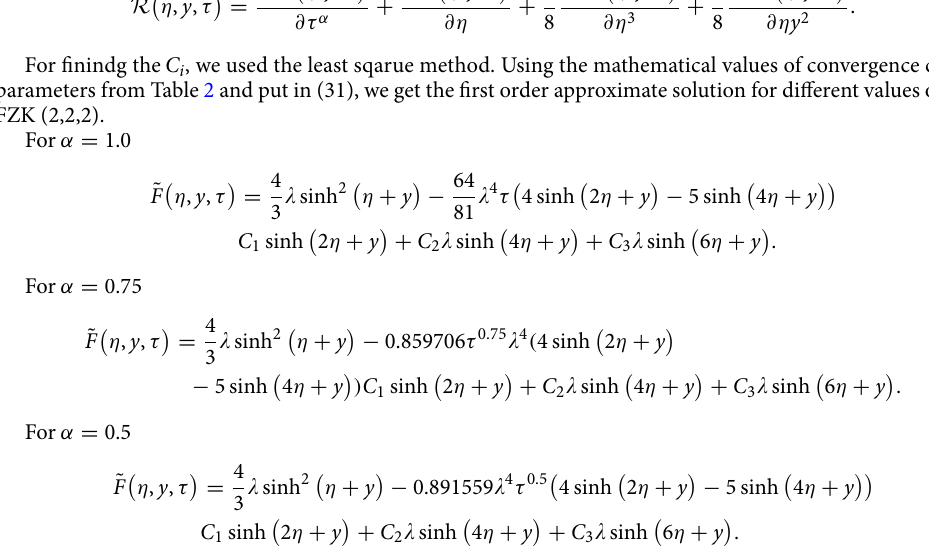
Figure 1 shows 3D plots approximate verses exact solutions for the nonlinear fractional order FZK(3,3,3) equation when α = 1, y = 0.1 . Figure 2, displays the 2D schemes of the residual, obtained by the suggested technique for α = 0.5 to fractional order FZK(3,3,3) equation. Figure 3, displays the 2D designs of approxi- mate solutions obtained by the suggested mode for different values of α while τ = 0.1, y = 0.2 to fractional order FZK(3,3,3) equation. Figure 4, shows the 3D plots obtained by the suggested process to fractional order